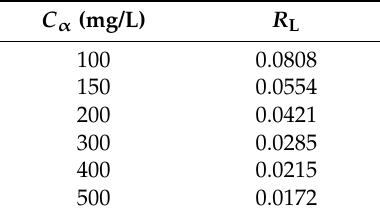
Table 4. The Langmuir-based R L